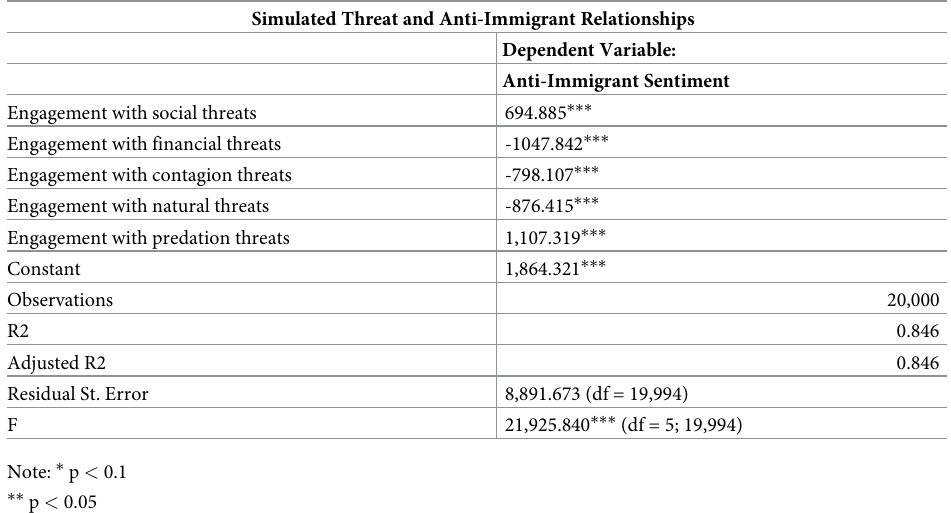
Table 8. Regression data from simulated data regarding anti-immigrant sentiment as a dependent variable and threat inputs as independent